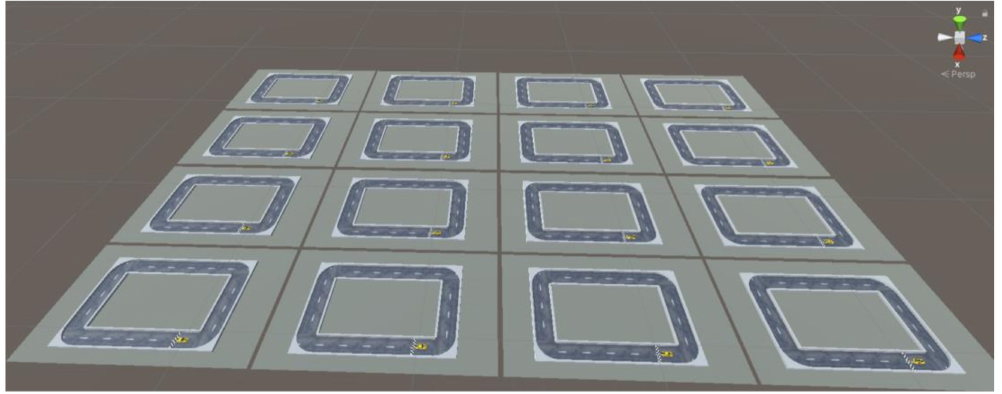
Figure 11. Vehicle autonomous driving policy training learning environment.